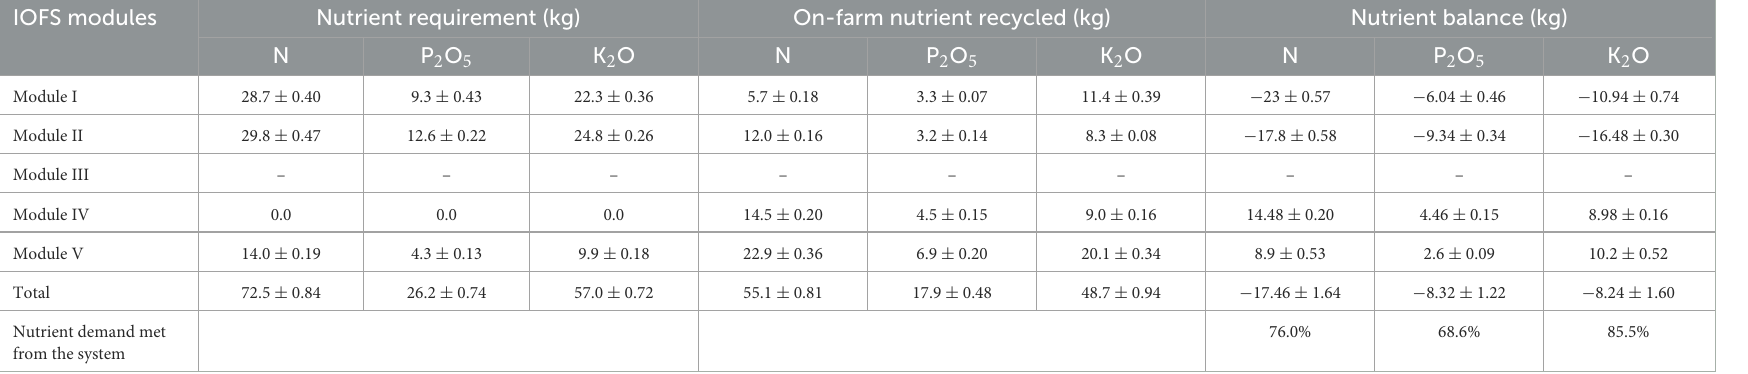
TABLE 6 On-farm nutrient supply balance sheet in the IOFS model of Mrs. Skola Kurbah (after 5 years). IOFS